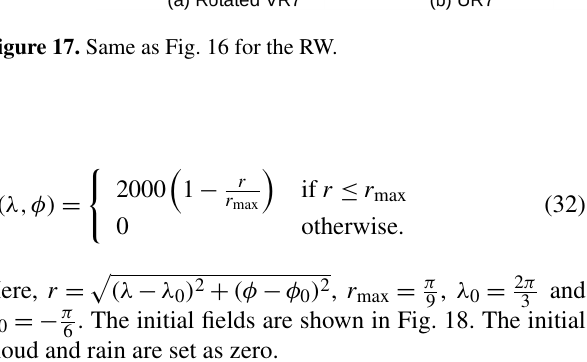
Figure 17. Same as Fig. 16 for the